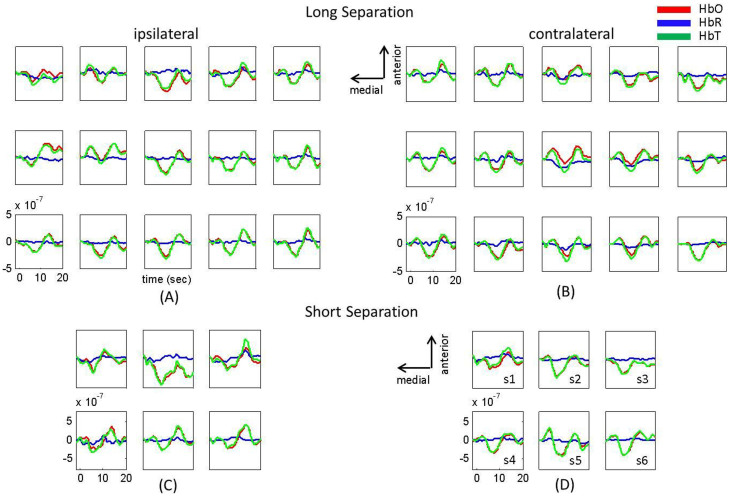
Hemodynamic response to left thumb noxious electrical stimuli at long separation channels (panels A and B) and short separation channels (panels C and D) without short separation regression.Group average results (n = 11) for the changes in HbO (red), HbR (blue), HbT (green). The letter-number combinations on panel D (from s1 to s6) correspond to the same letter-number combinations on Figure 7, panel B.